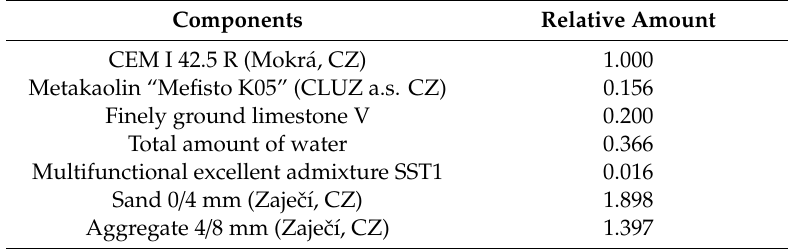
Table 1. Composition of fresh High-Performance Concrete: Relative amount per